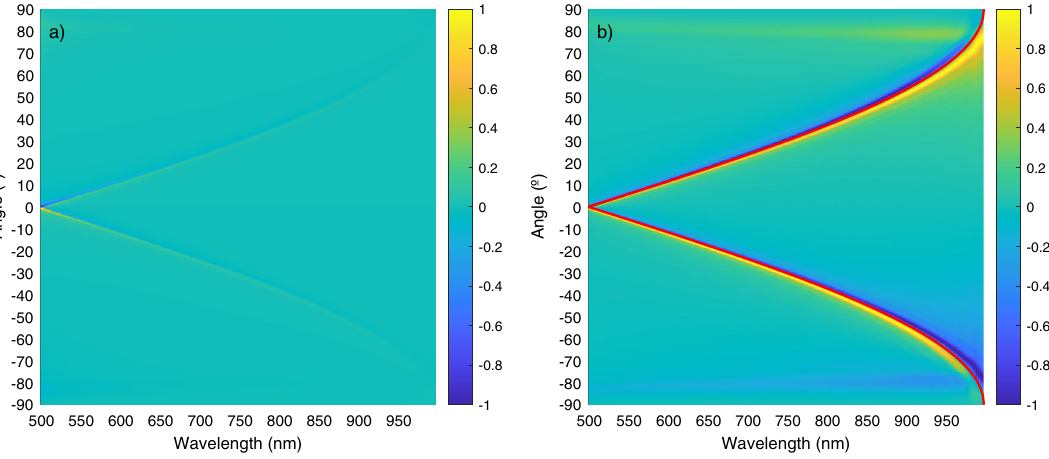
Figure 2. Color map of the torque versus wavelength and orientation angle. Yellow regions corresponds to positive torques (anti-clock wise oriented), blue regions to negative torques (clock wise oriented). In ( a ) The torque is normalized to the maximum absolute value. In ( b ) the torque is normalized to the maximum value for each wavelength. The resonant angle promoting cumulative field enhancement is marked with a red